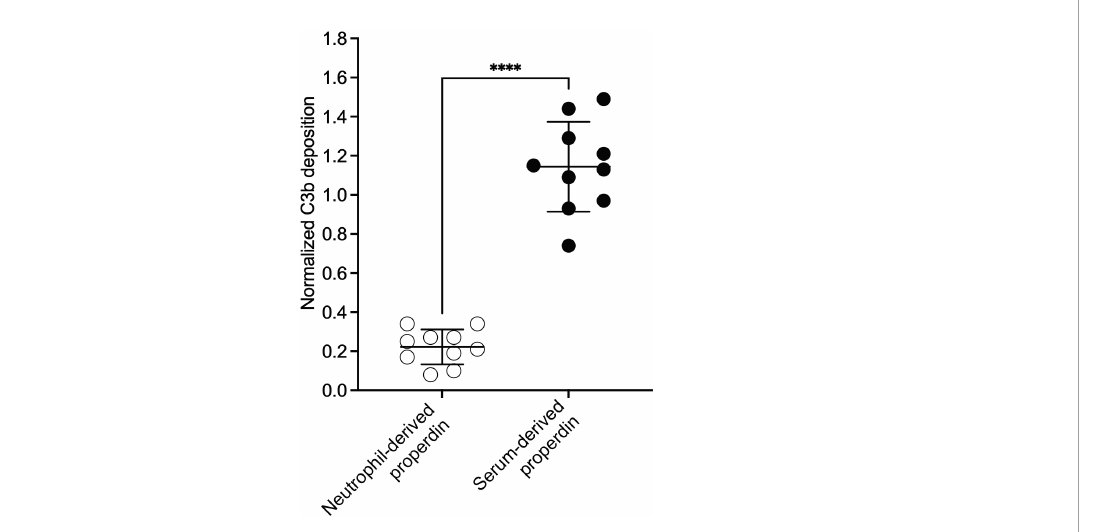
FIGURE 8 Neutrophil-derived properdin had signi fi cantly lower function than serum-derived properdin, when assessed in the properdin functional ELISA, at equivalent concentrations. Properdin function was quanti fi ed by properdin functional ELISA where the readout was C3b deposition as described in “ Materials and Methods ” (section 2.8.2). Data is graphed minus background of samples containing no properdin during the properdin capture step. Properdin function in phorbol-12-myristate-13-acetate (PMA) activated neutrophil supernatant and serum collected from 10 healthy donors was quanti fi ed. All samples were tested at equivalent concentrations (300 ng/ml). Results are shown as mean and standard deviation from two independent experiments with triplicates. Signi fi cant differences in C3b deposition between samples was assessed by unpaired t test; p<